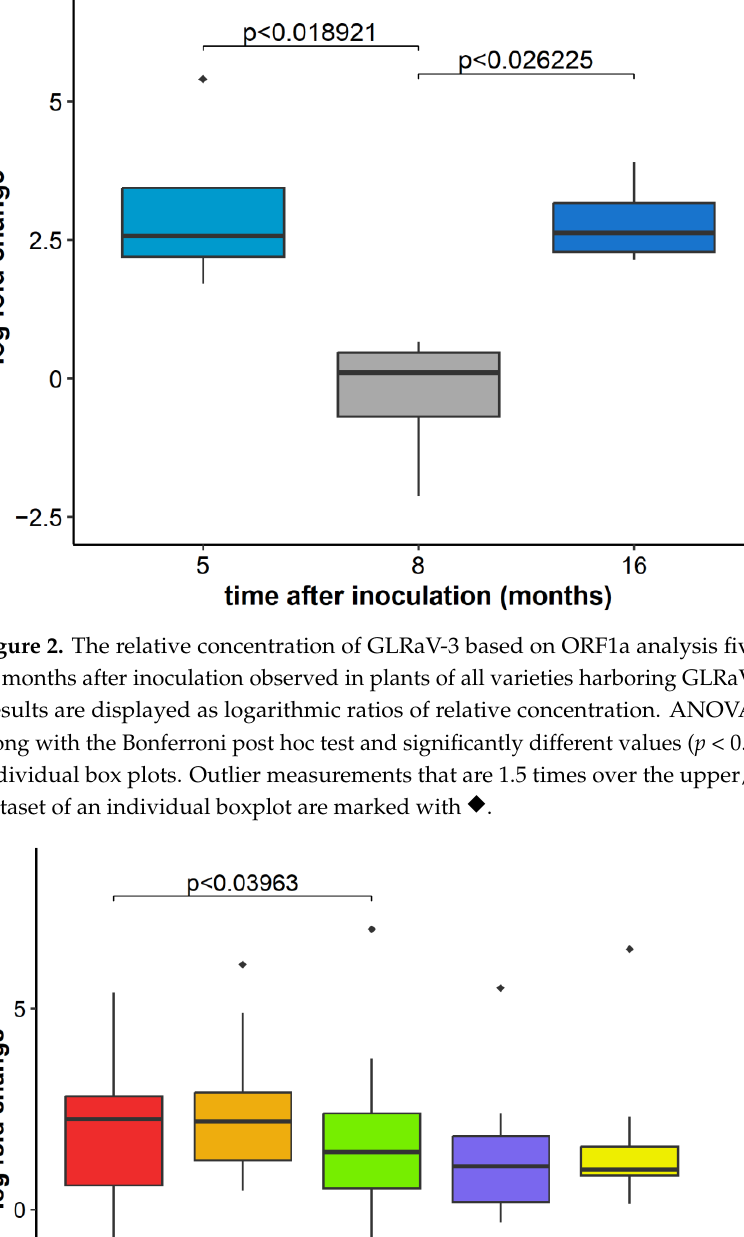
Figure 3. Multiple comparisons of relative concentration of GLRaV-3 ORF1a observed 16 months after inoculation of all plants of all varieties infected with the same inoculum (II, Q, X, Y or Z). Results are displayed as logarithmic ratios of relative concentration. ANOVA test was performed along with Dunnett’s post-hoc test and significantly different values ( p < 0.05) are marked over in- dividual box plots. All concentrations were compared with the one of inoculum II (control) being the one harboring only GLRaV-3. Outlier measurements that are 1.5 times over the upper/lower quartile of the dataset of an individual boxplot are marked with ◆ .